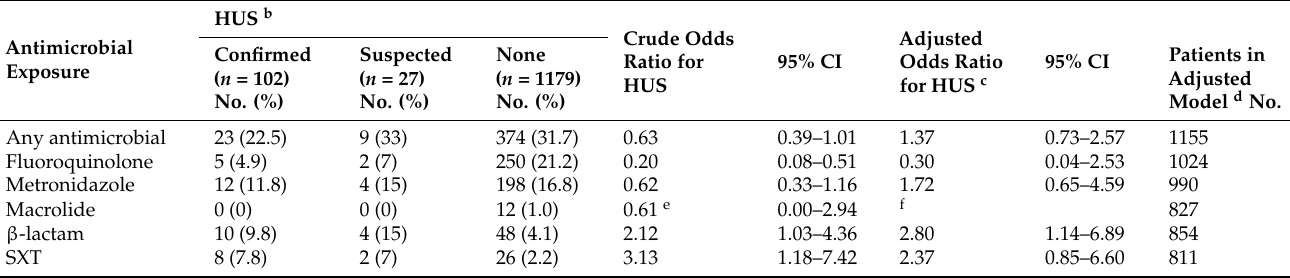
Table 4. Frequency of antimicrobial exposure by HUS status and the association between recorded antimicrobial exposures during the first 7 days of illness and the development of confirmed HUS a .